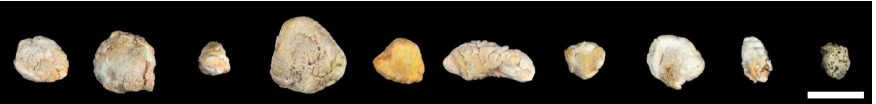
Figure 1. Sialoliths are unique in shape and surface composition. Ten representative submandibular stones ( n = 30) under oblique white light, illustrating the individual surface differences between stones and even within the same sialolith. Note the different shapes and appearances that suggest a discontinuous and variable sialolithogenesis in di ff erently shaped molds. Scale bar: 10 mm.